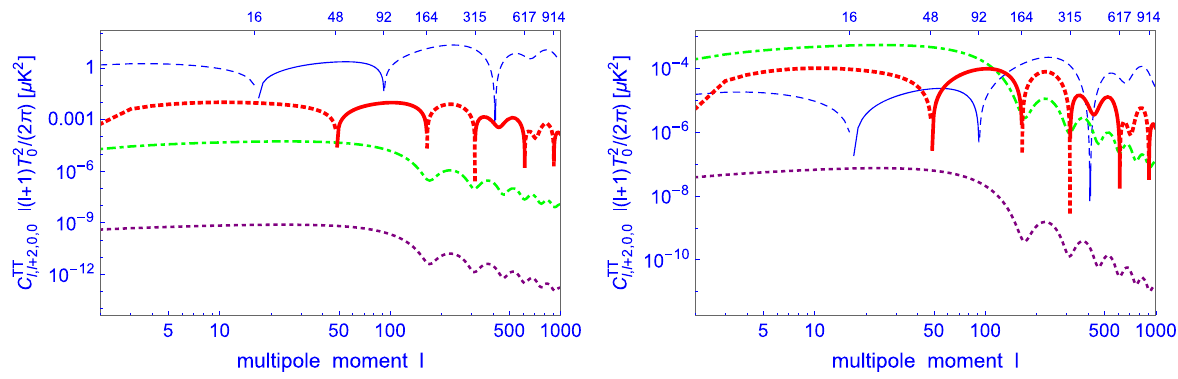
Fig. 2 The magnitude of the TT spectra C TT anisotropy in the scalar perturbations (the upper blue dashed-solid curve); by the anisotropy in the tensor perturbations (the green dotted- dashed curve); by the cross-correlations (the thicker red dotted-solid curve); and by the linear polarization (the bottom purple dotted curve) are shown respectively. The dotted (red and purple), dashed (blue), and dotted-dashed (green) curves denotes the regions where C TT Thelefthandsideandrighthandsidefigurescorrespondtothecanonical